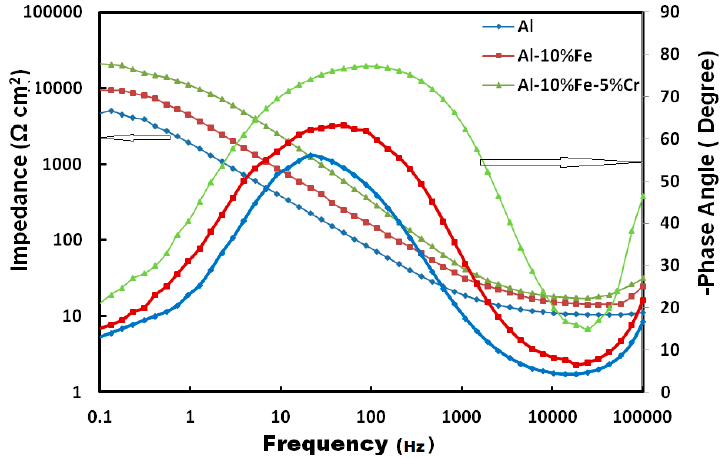
Figure 7. Bode plot of pure Al, Al ‐ 10% Fe and Al ‐ 10% Fe ‐ 5% Cr alloy immersed in 3.5% NaCl after 1 h at room temperature.